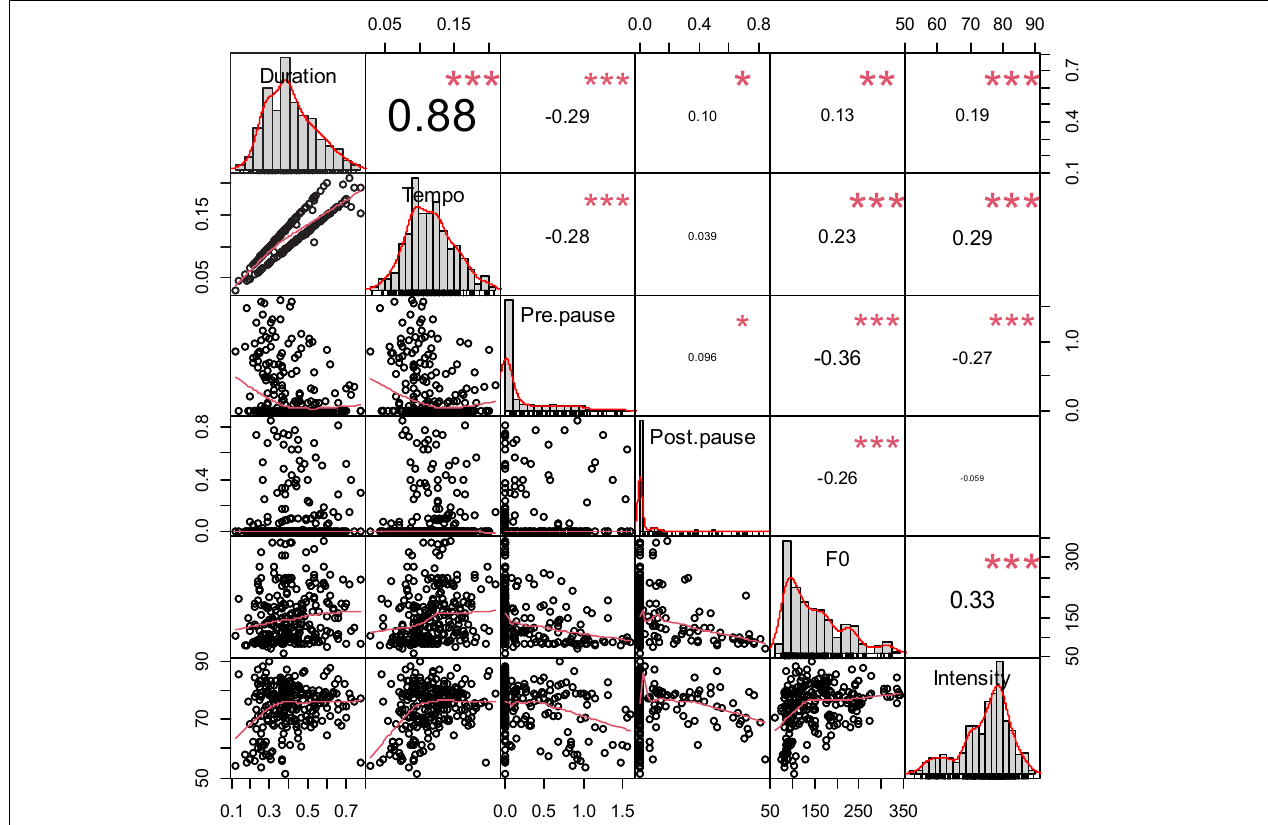
FIGURE 6 | Correlation between the prosodic features of ni zhidao in four sentence